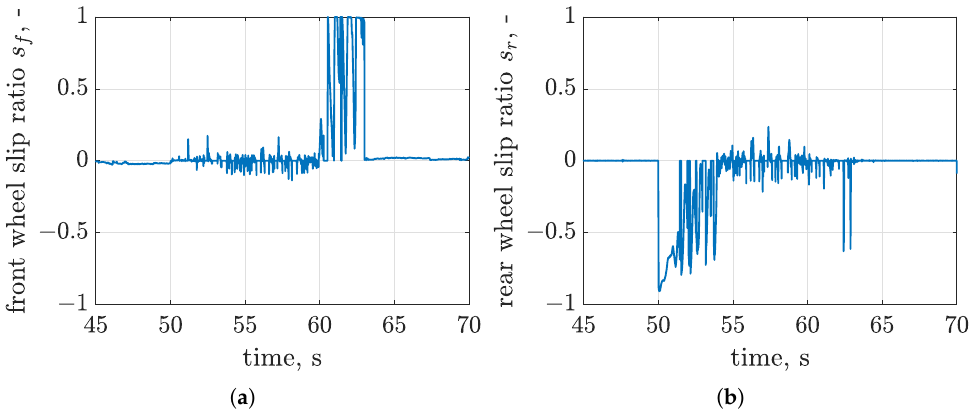
Figure 9. Time diagrams of slip ratios: ( a ) front wheel during braking, ( b ) rear wheel during accelerating.